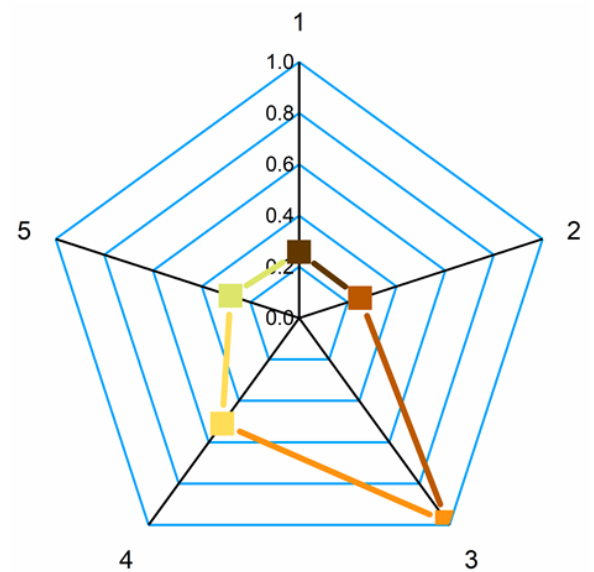
Figure 10. Diagram of relative efficiency indicators for time, maximum values of ( D / D 0 ) 2 max , and critical breakup temperature for the following compositions: 1 — C50W49D1; 2 — C50W49R1;